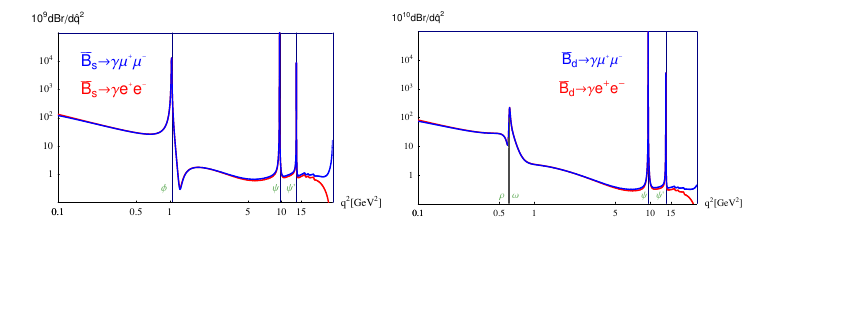
γ l + l − (left) and B γ l + l − (right) decays. Blue d → →